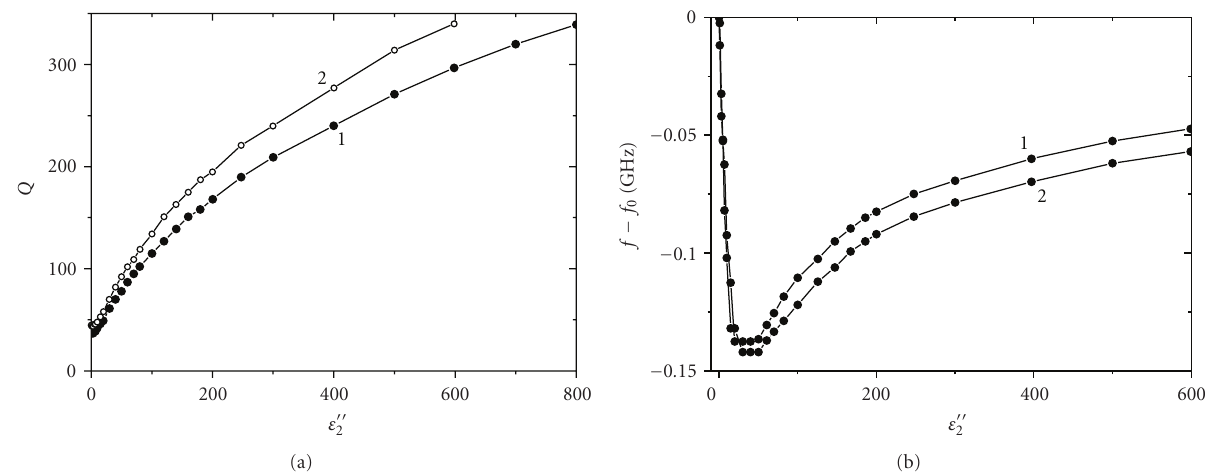
Figure 5: The dependence of Q -factor of the ball in high lossmedium Q (a) and resonance frequency shift f (b) with respect to the frequency f 0 on imaginary CP part of high loss outer medium ε (cid:2)(cid:2) 2 ( f 0 = 31 . 82GHz is the operating resonance frequency at ε (cid:2)(cid:2) 2 = 0). The diameter of the ball is 2 a = 5 . 56cm. Polar oscillation index is n = 20 and radial index is l = 1 (the curve 1) l = 2 (the curve 2), ε (cid:2) 2 = 20. The stars denote experimental data points from [13] (the outer medium was taken as water-ethanol solutions at 23 ◦ C from 10% to 40% ethanol in water [22]).